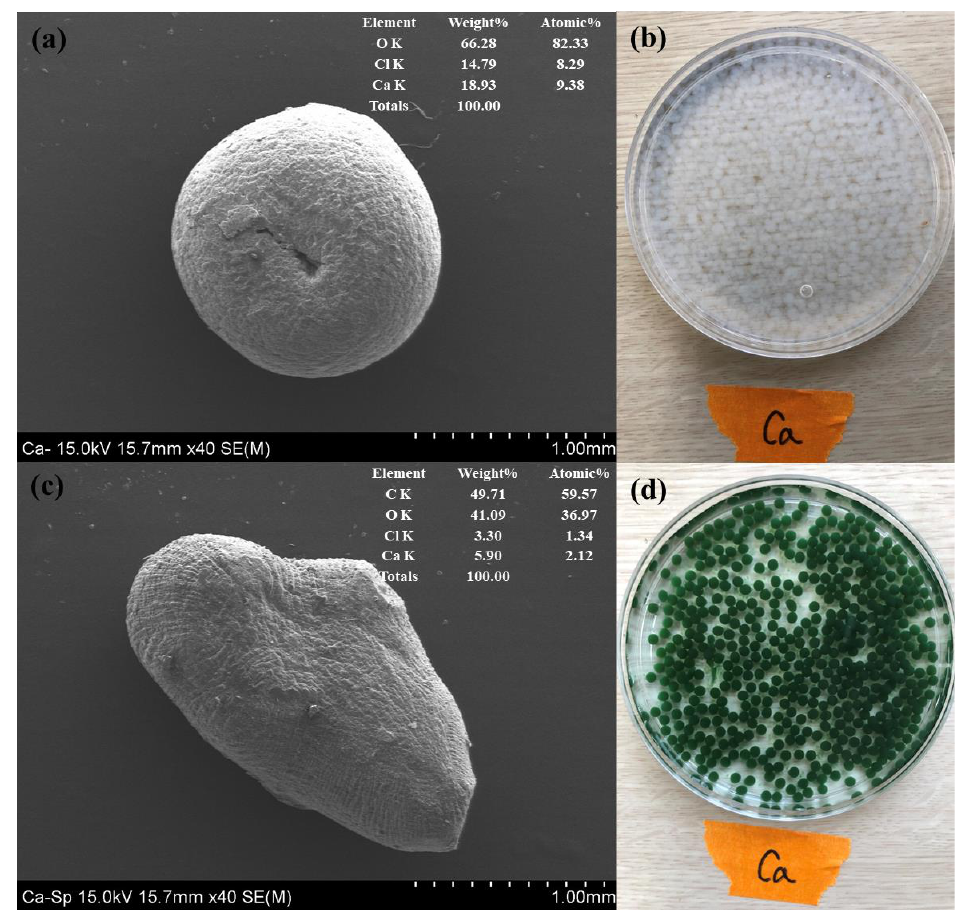
Figure 4. SEM-EDS images of Ca-SA ( a ) and S.P@Ca-SA ( c ) and digital images of Ca-SA ( b ) and S.P@Ca-SA ( d ).